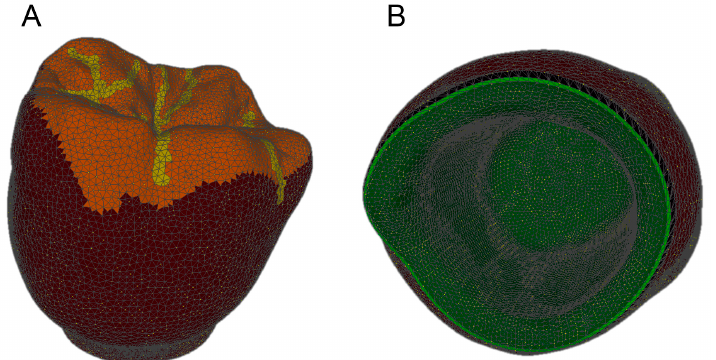
Figure 4. The provisional crown (PLAN1) as visualized in an open-access software (Meshlab ® , Pisa, Italy). ( A ) external view of the mesh; ( B ) internal view of the mesh with the margin line clearly visible (in implantology, the margin line is designed on a library file, and not on a mesh, therefore it is perfect).